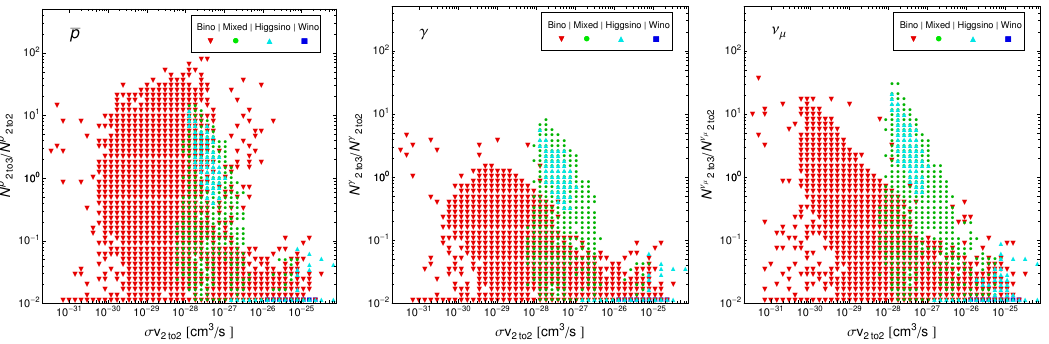
Figure 9 . Same as (cid:12)gure 8, but now showing the integrated yields, for E X > m (cid:31) = 10, against the total two-body cross section instead of the neutralino